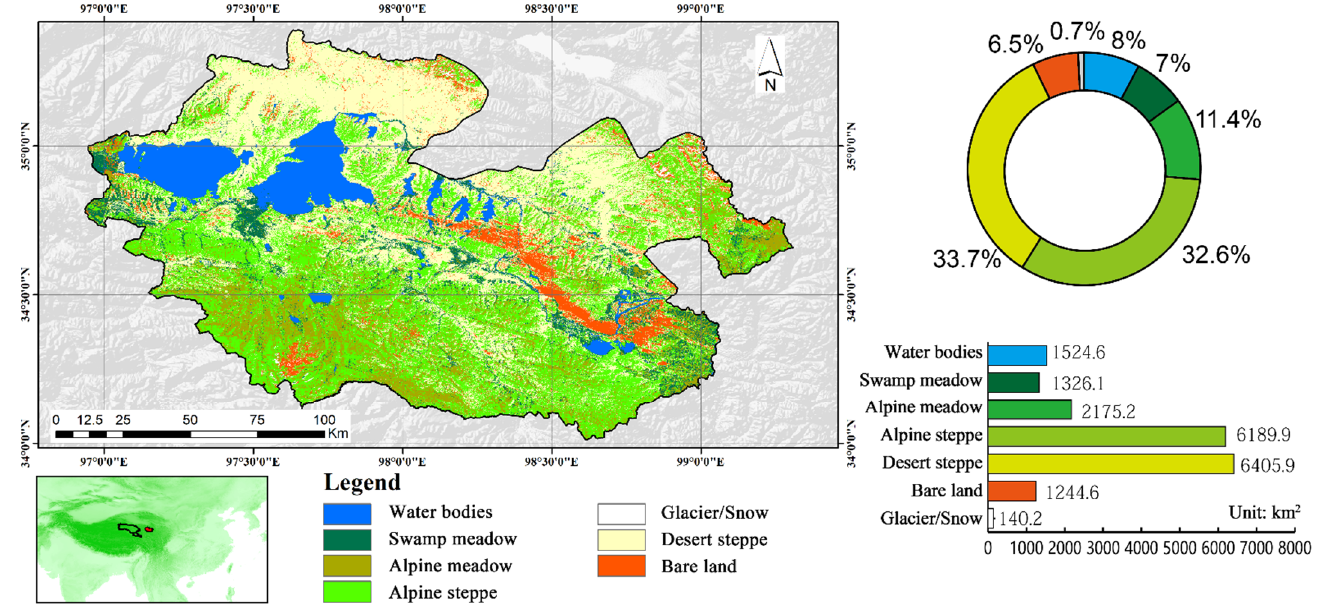
Figure 8. Vegetation classification results of 2021 in the headwater of Huang River in Sanjiangyuan National Park.